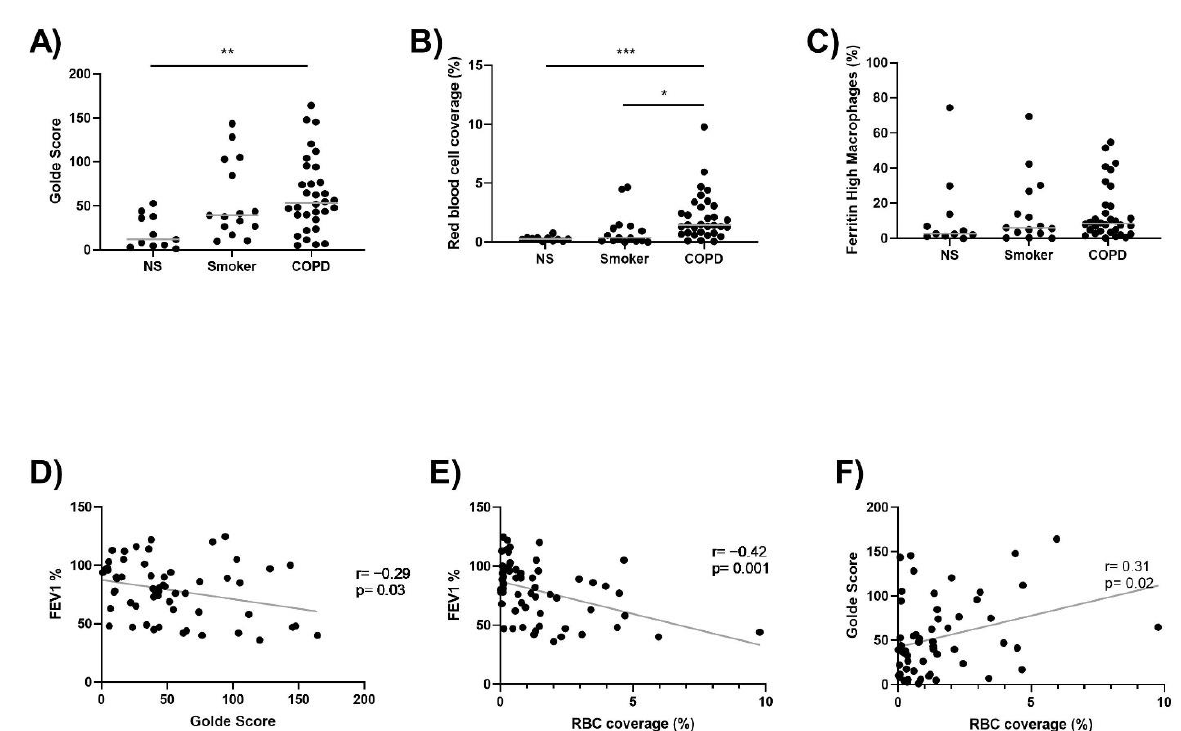
Figure 1. Lung macrophage iron levels and RBC coverage is increased in COPD. ( A ) Lung tissue sections were stained with Perls Prussian Blue. Lung macrophage iron levels were quantified in 11 NS, 15 S and 32 COPD patients. ( B ) H&E staining was carried out to assess RBC coverage in the alveolar space in 11 NS, 15 S and 32 COPD patients. ( C ) The percentage of ferritin high lung macrophages in 11 NS, 15 S and 32 COPD patients. ( D ) Correlation between FEV1% and Golde score ( r = − 0.29, p = 0.03). ( E ) Correlation between FEV1% and RBC coverage of the alveolar space ( r = − 0.42, p = 0.001). ( F ) Correlation between Golde score and RBC coverage of the alveolar space ( r = 0.31, p = 0.02). Kruskal–Wallis multiple comparisons test was used to test differences between groups. Correlation data are plotted as individuals with linear regression ( D – F ). * = p < 0.05, ** = p < 0.01, *** = p < 0.001. Data presented as individuals with median.